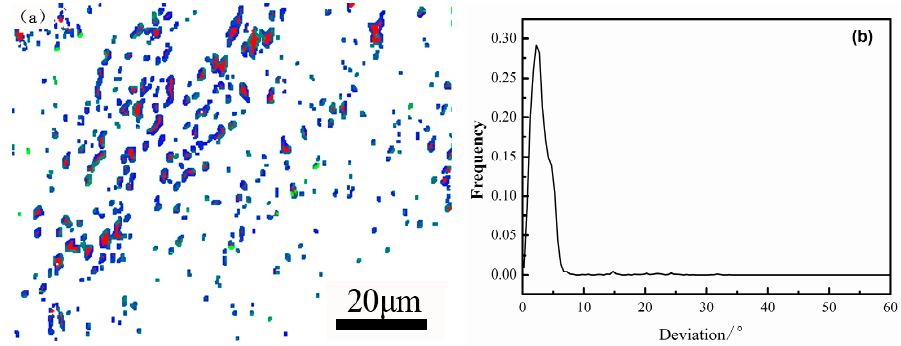
Figure 5. ( a ) K-S orientation relationship of bcc and fcc phase of the supermartensitic stainless steel and ( b ) the delivation angle of the ideal K-S orientation relationship boundaries.